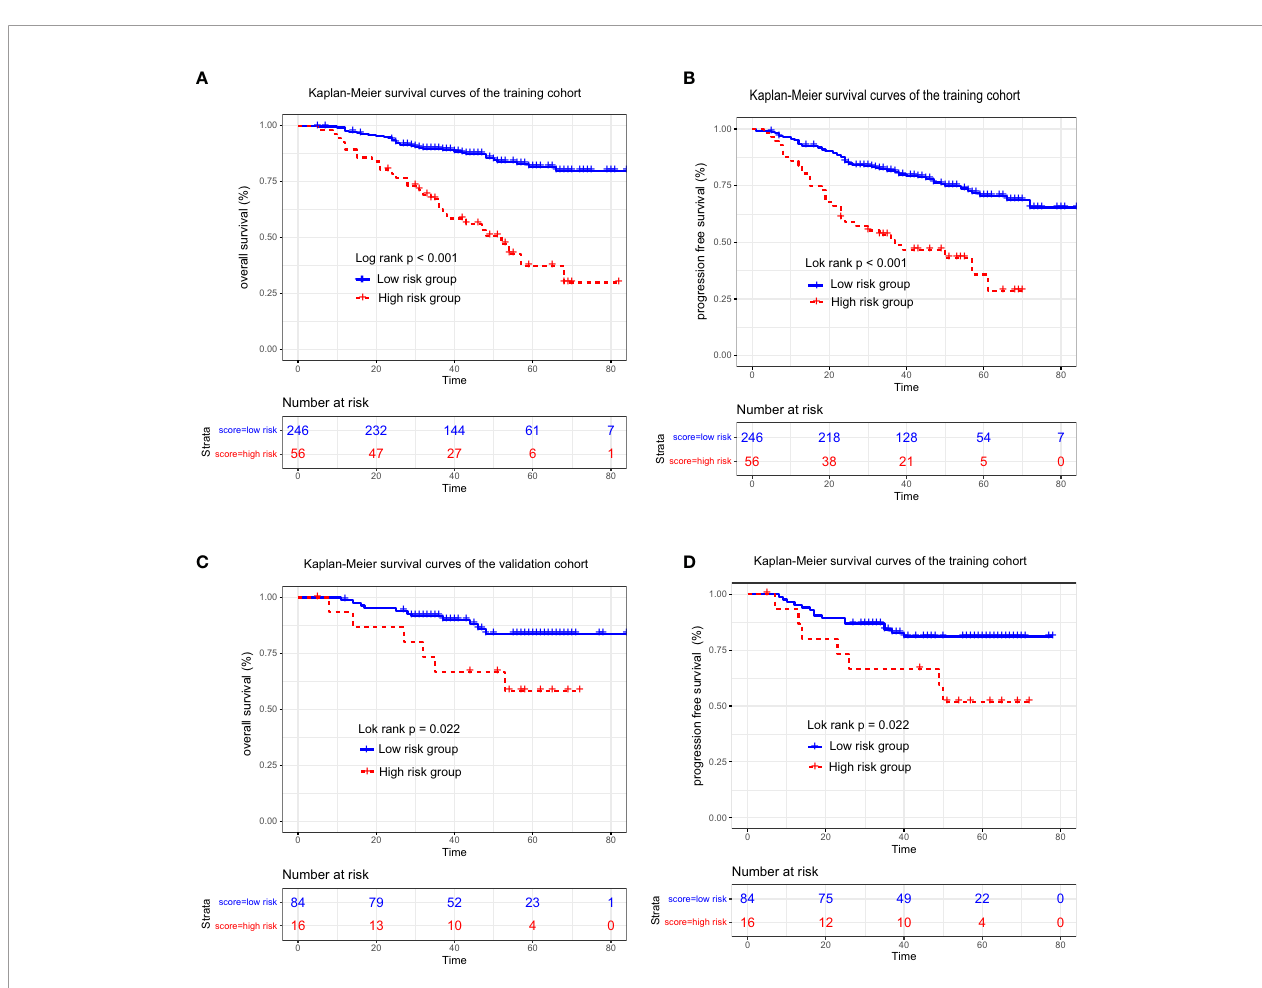
FIGURE 5 | Kaplan-Meier survival curves for patients strati fi ed based on the nomogram in the training (A, B) and validation cohort (C, D)